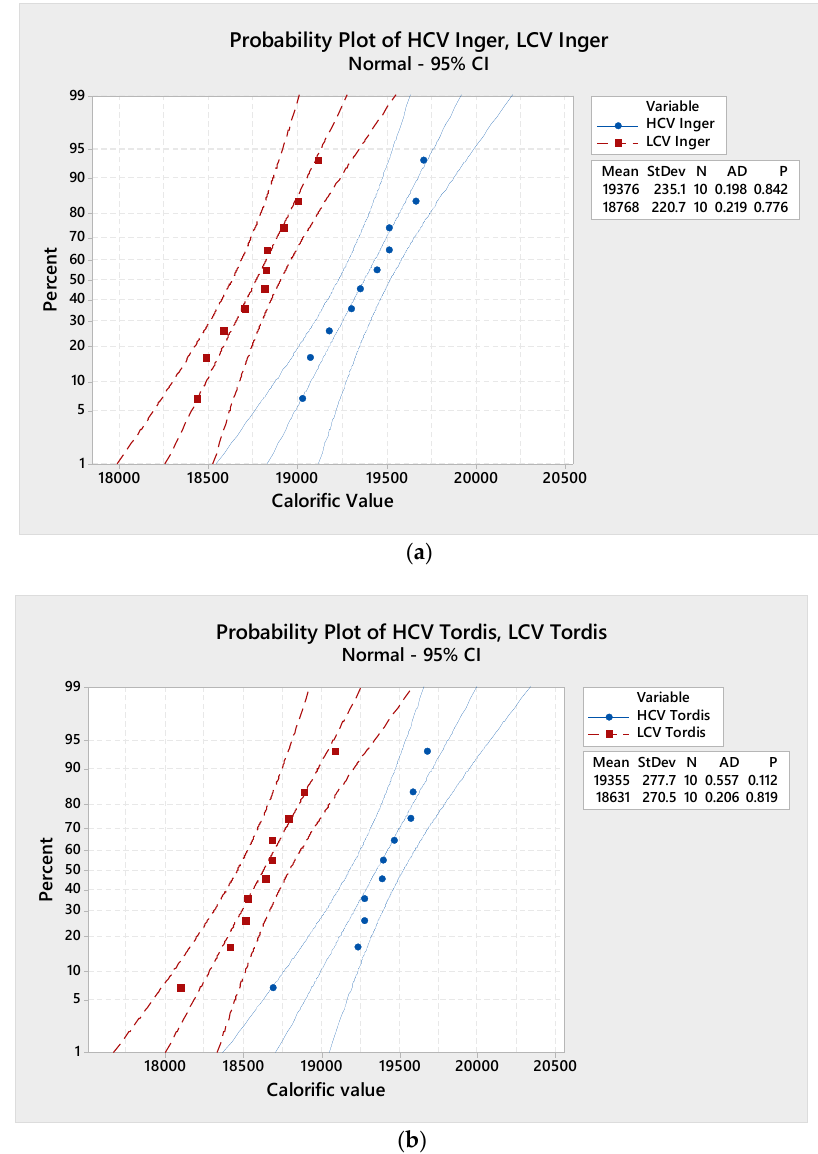
Figure 8. Probability plot of calorific value for Inger ( a ) and Tordis ( b ) clones.